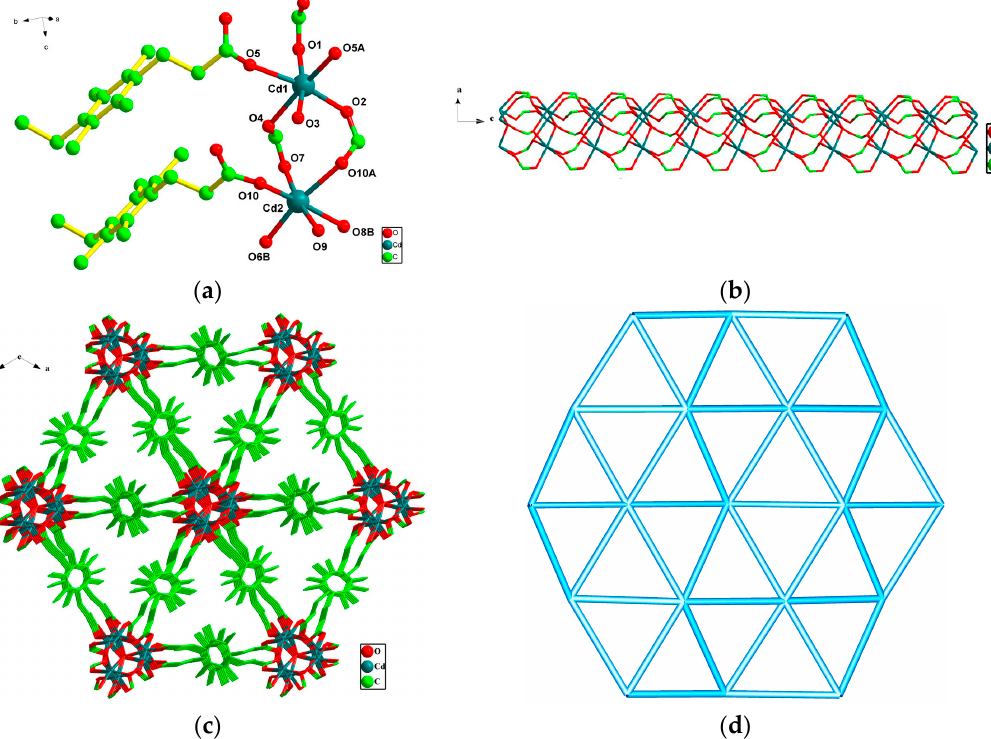
Figure 2. ( a ) Surrounding environment map of Cd(II) in complex 1 , symmetric opcode: A = 1 − y, x − y, z; B = x, y, 1 + z. ( b ) Cd(II)/ X2 − 1D chain. ( c ) The 3D structure diagram of complex 1 . ( d ) Schematic view of the 3D topology network for 1 .